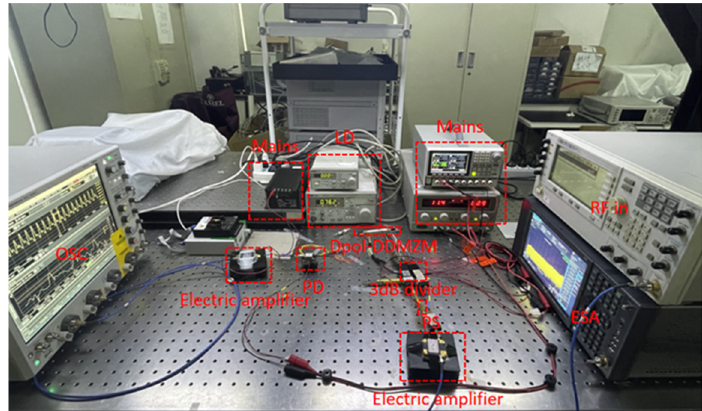
Figure 5. Physical map of the built experimental link .